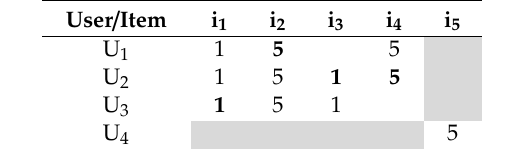
Table 2. User-item rating database excerpt after the execution of the preprocessing step of CF